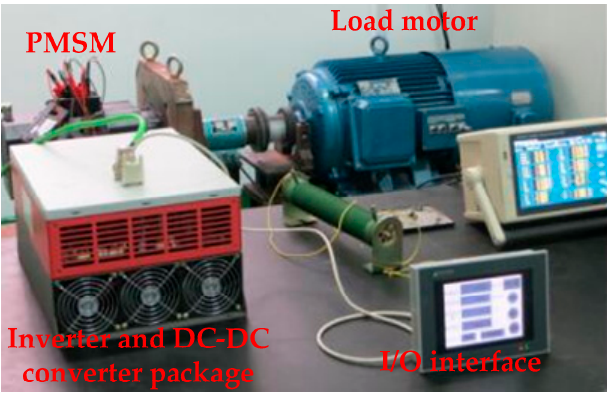
Figure 10. Simulation comparisons of the two controllers against permanent magnet demagnetization